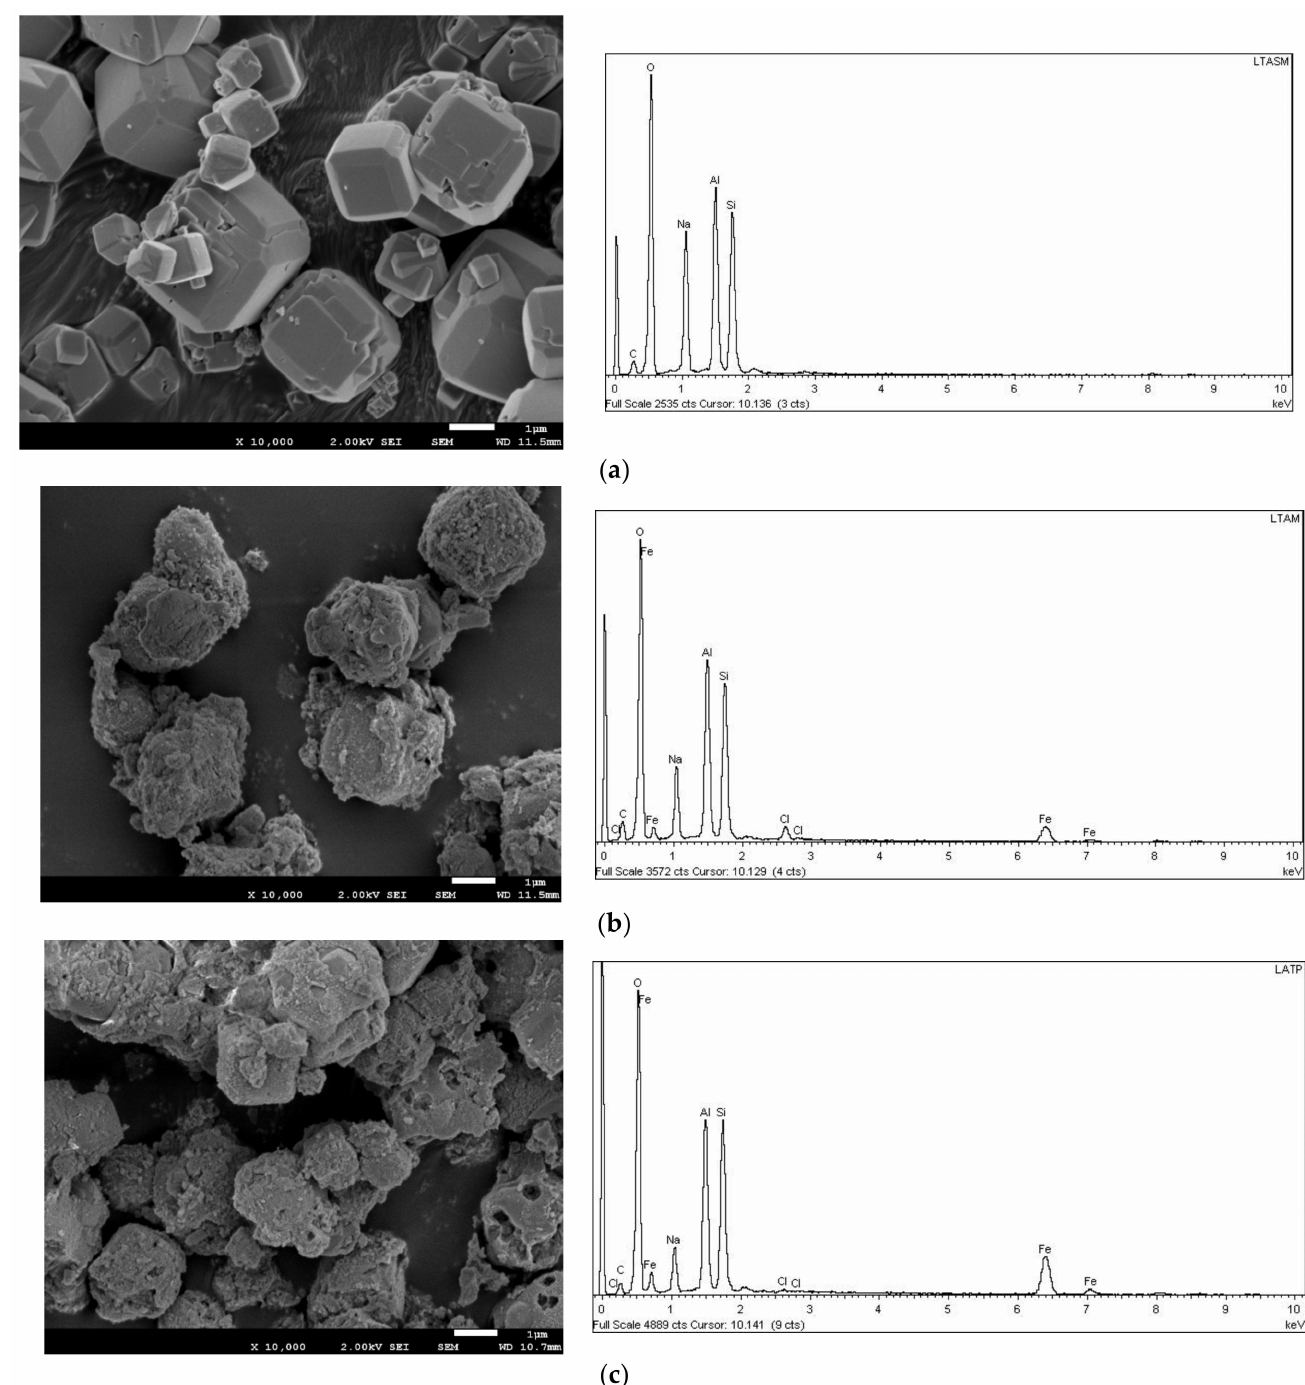
Figure 1. FSEM-EDX of the LTA zeolite: ( a ) parent form LTA, ( b ) iron form LTA-Fe, and ( c ) loaded